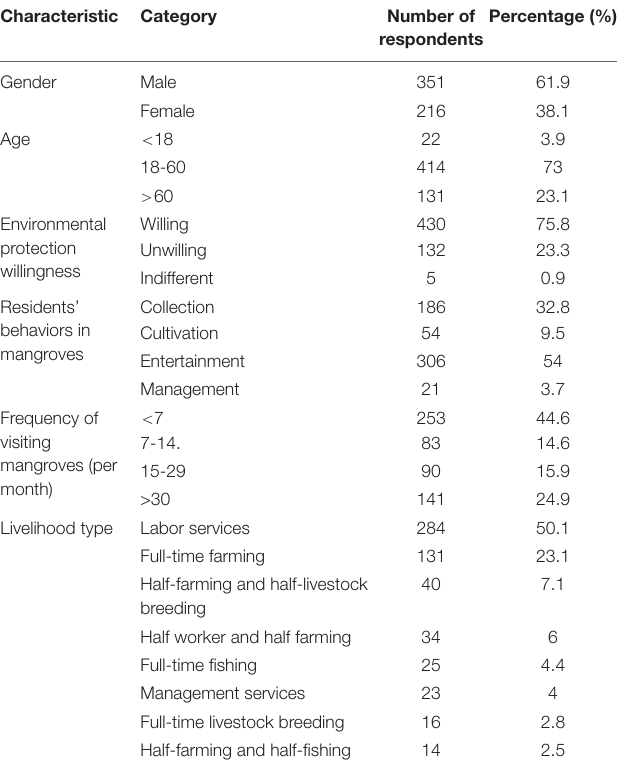
TABLE 2 | A descriptive analysis of the basic characteristics of residents.